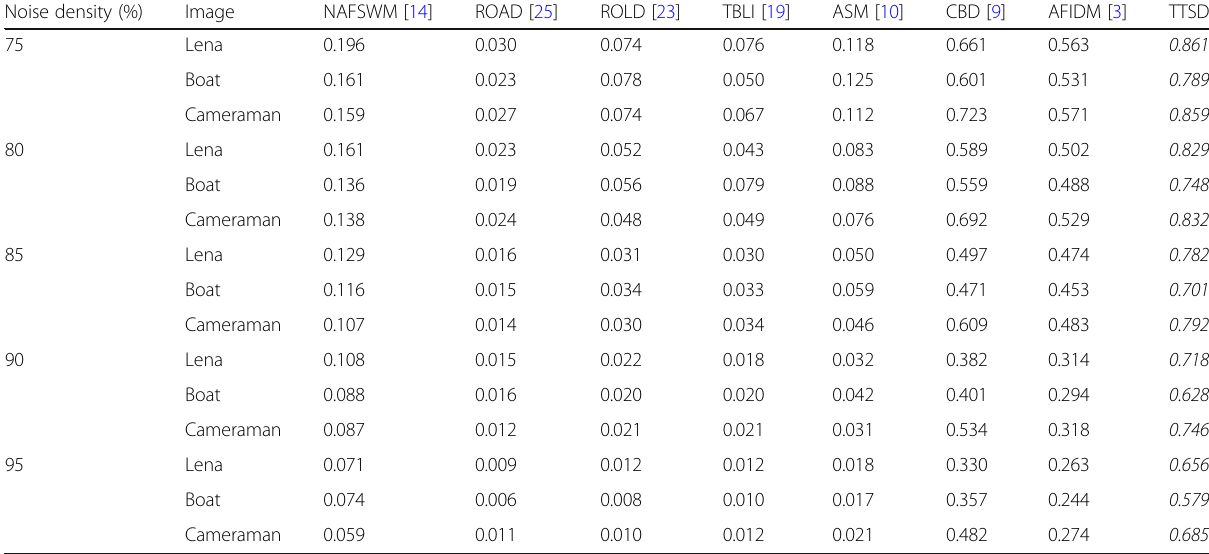
Table 3 Restoration results in SSIM for Lena, Boat, and Cameraman images corrupted by RVIN Noise density (%)